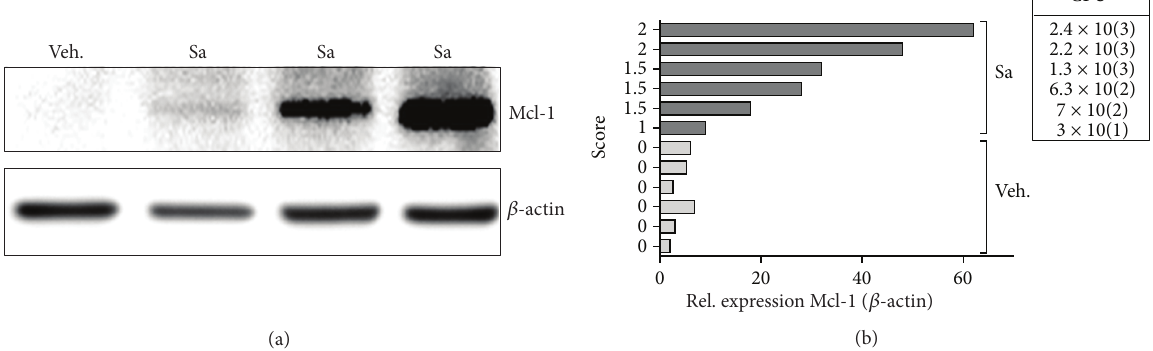
F 3: Exposure to S. aureus triggers Mcl-1 production in vivo. (a) Immunoblot reveals increase in Mcl-1 expression in in�amed joints derived from three individual S. aureus -infected mice (Sa) in comparison to noninfected animals (Veh.). A representative immunoblot from three separate experiments is shown. (b) e expression of Mcl-1 in joints correlates with infection score and bacterial load determined as described in Section 2. Data represents Mcl-1 levels in noninfected (Veh.; densitometric analyses of western